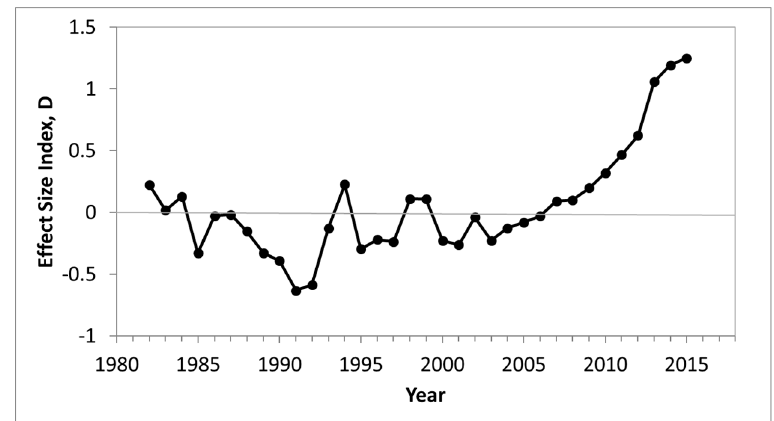
Figure 5. The temporal trend of the Cohen’s D Effect Size Index for the difference between the mean NDVI values in Turkey and Syria (Figure 4). Until 2011, the magnitude of D was considerably small but